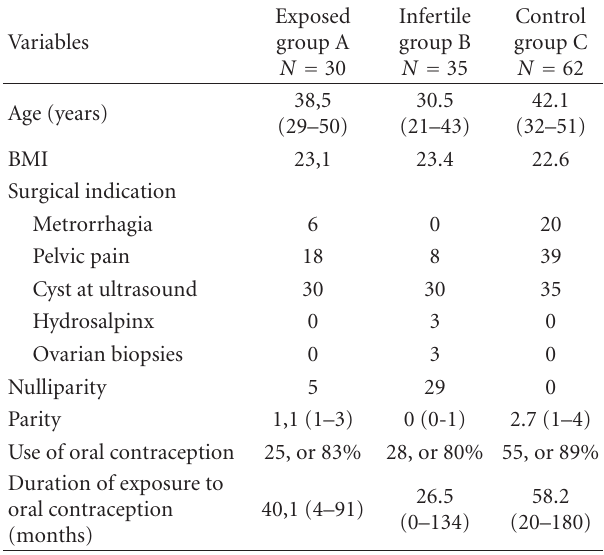
Table 1: Characteristics of the study population at the time of surgery.